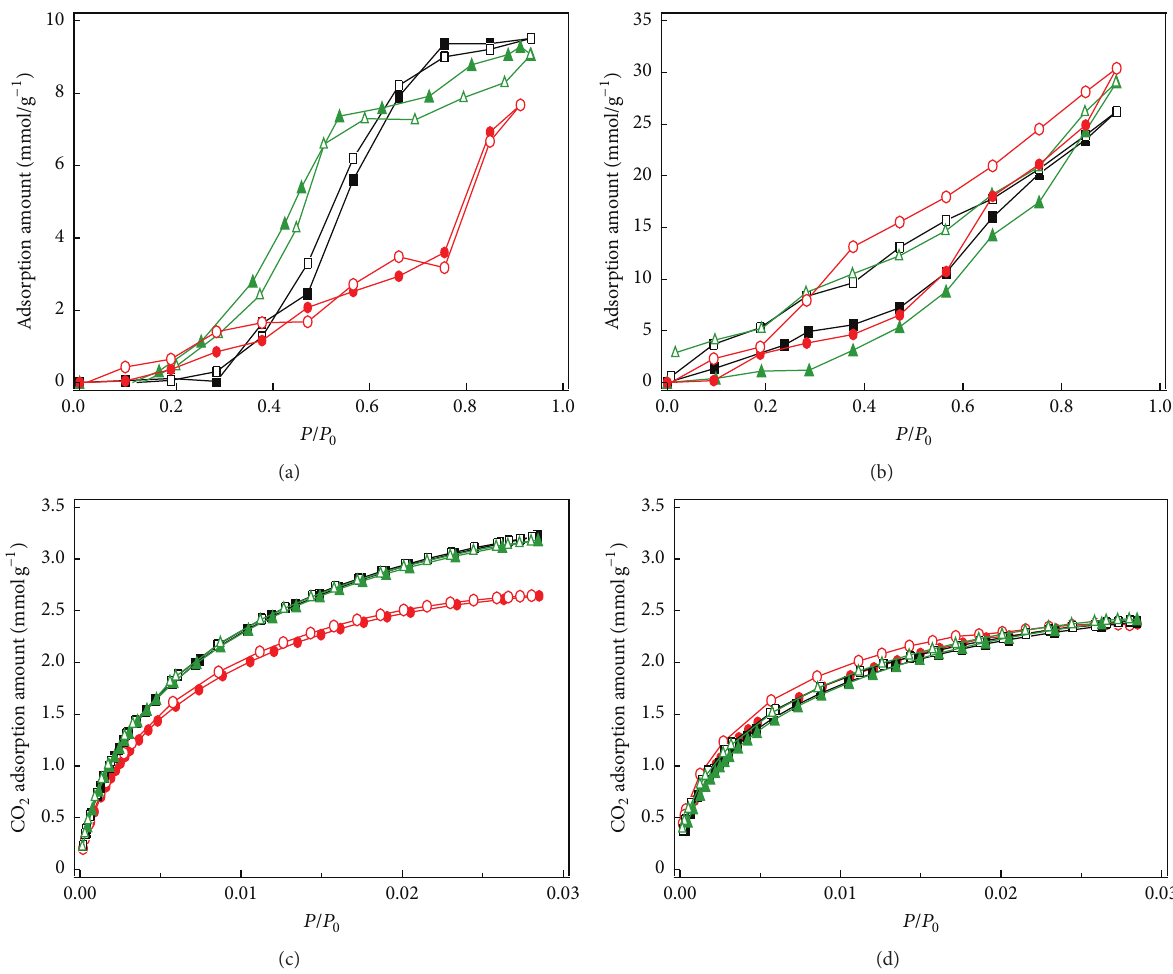
Figure 5: Water sorption and CO 2 sorption isotherms. Water sorption isotherms at 303 K for CAs (a) and x CA–KCs (b). CO 2 adsorption isotherms at 273 K under dry conditions for CA (c) and for x CA–KCs (d). Pore widths: black ◻ , 7 nm; green △ , 16 nm; red I ,